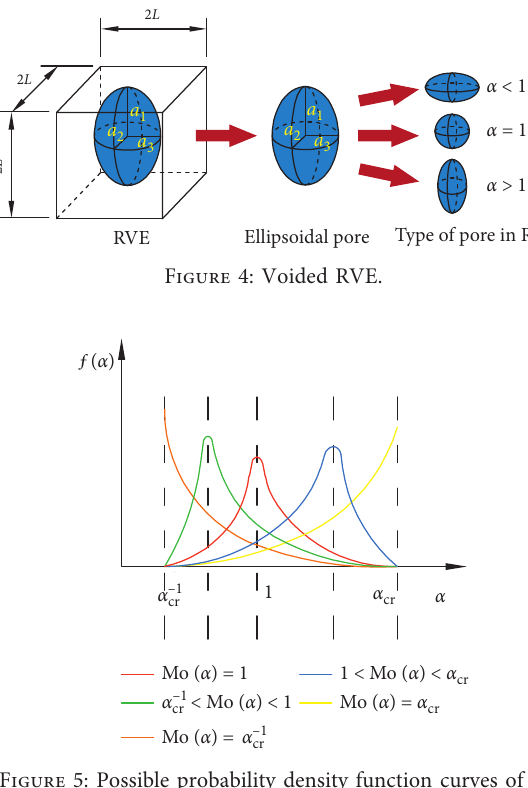
Figure 5: Possible probability density function curves of α